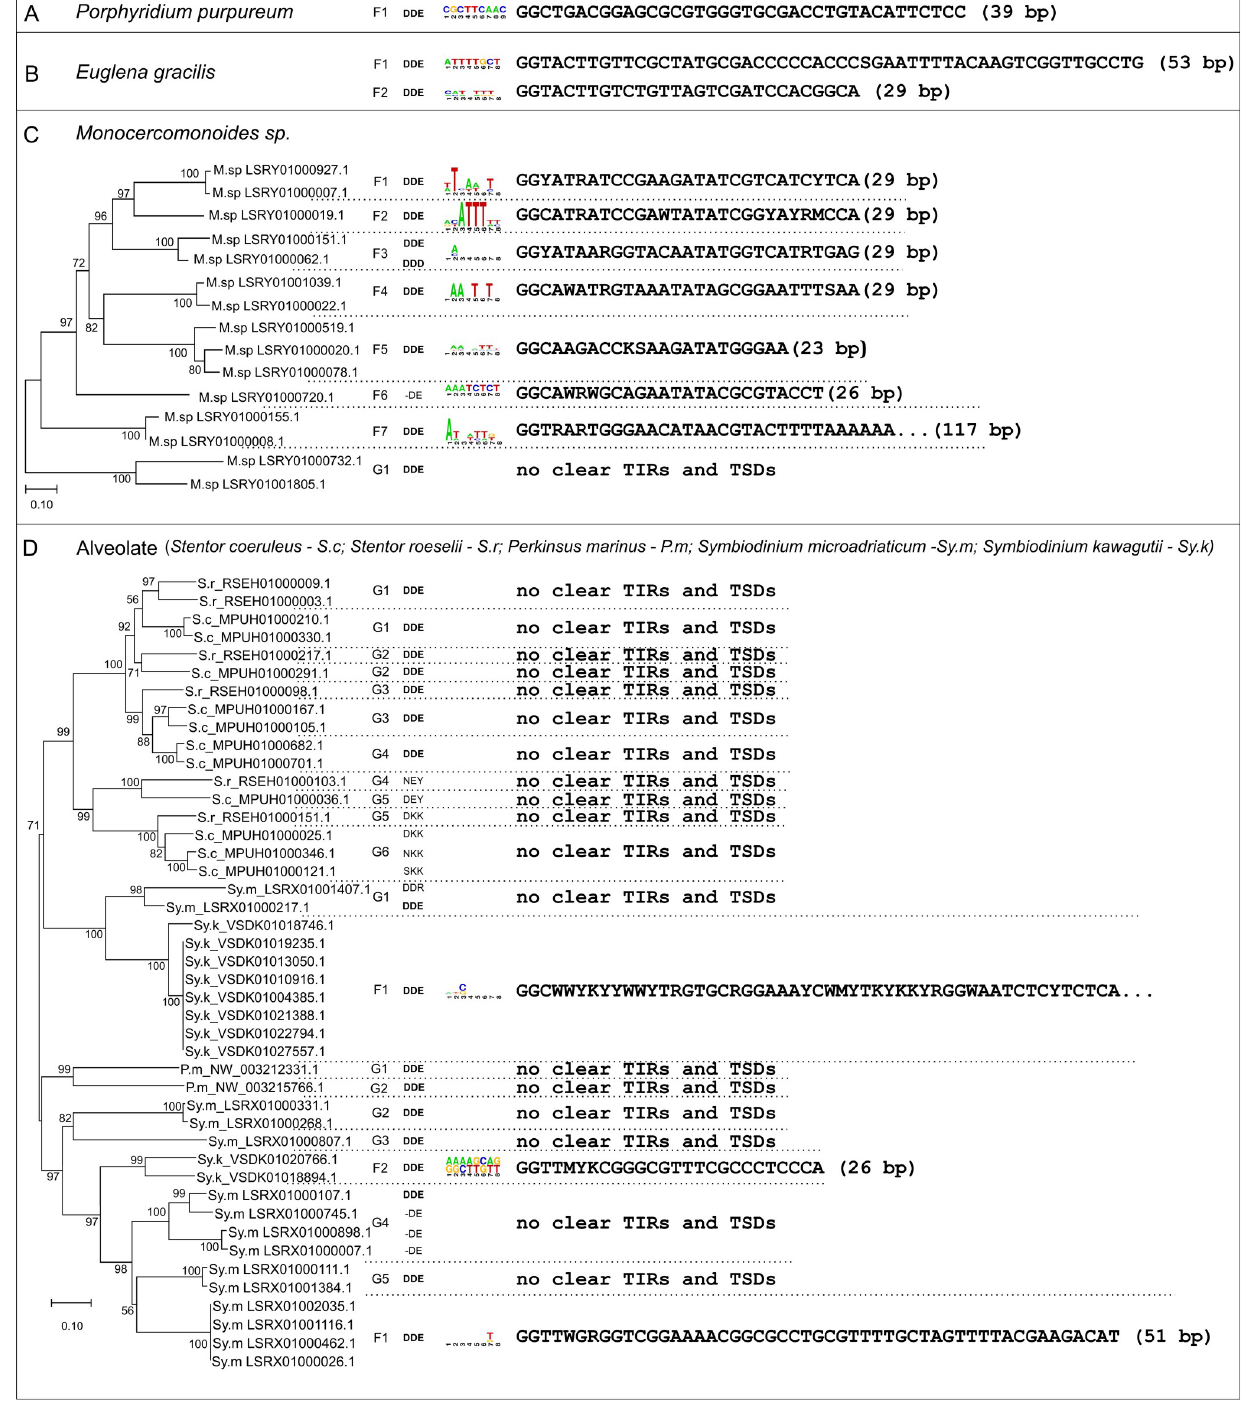
PLOS ONE | https://doi.org/10.1371/journal.pone.0251133 May 6, 2021 9 /